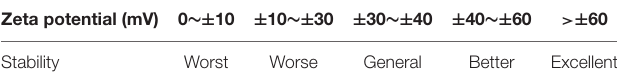
TABLE 5 | Stability classification of colloidal